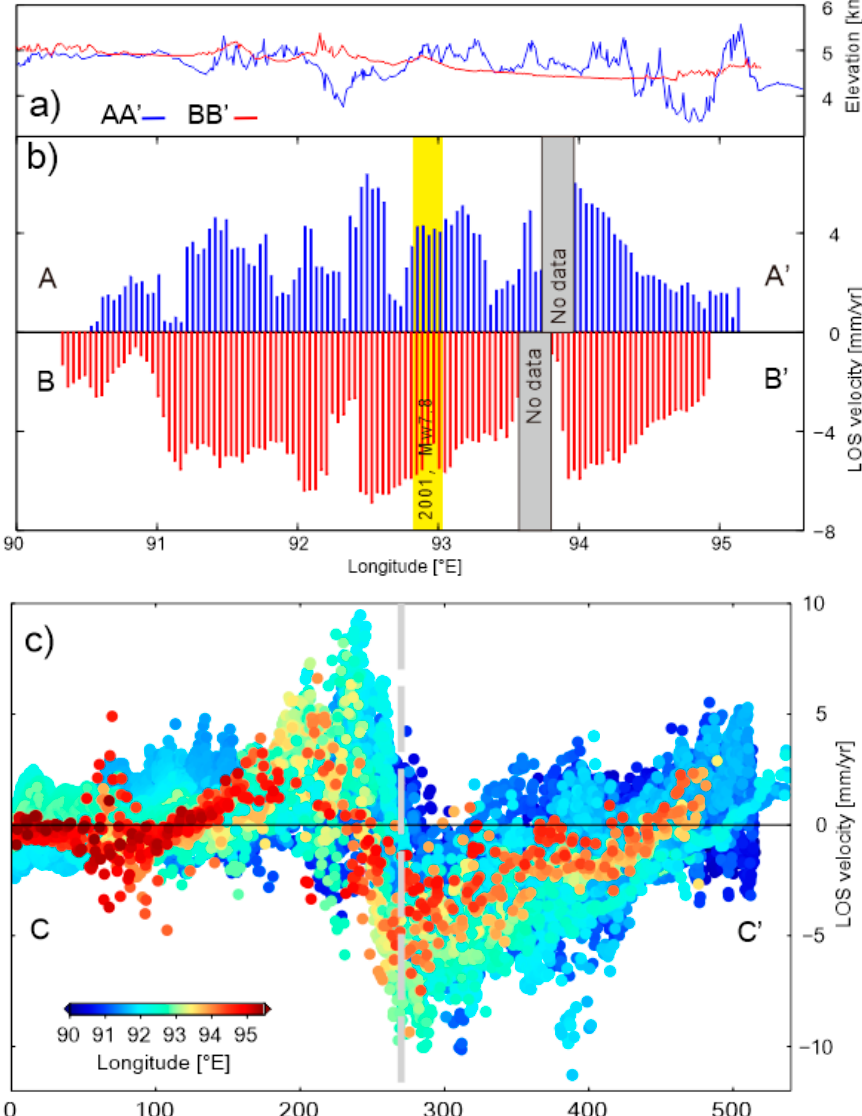
Figure 10. ( a ) Elevation variation along profiles AA’ and BB’ in Figure 9; ( b ) InSAR Line of sight (LOS) postseismic deformation velocity in 2003–2010 along profiles AA’ (blue bars) and BB’ (red bars). The yellow bar indicates the moment centroid (GCMT) of the 2001 Kokoxili earthquake; ( c ) InSAR velocity profile (2003–2010) along fault-perpendicular direction in CC’ encompassing the five tracks to show the variations both along and across the fault. The dot color indicates the longitude of position along the Kunlun fault. Vertical grey lines in ( c ) mark rough position of the Kunlun fault traces. The locations of profile AA’, BB’ and CC’ are shown in Figure 9.